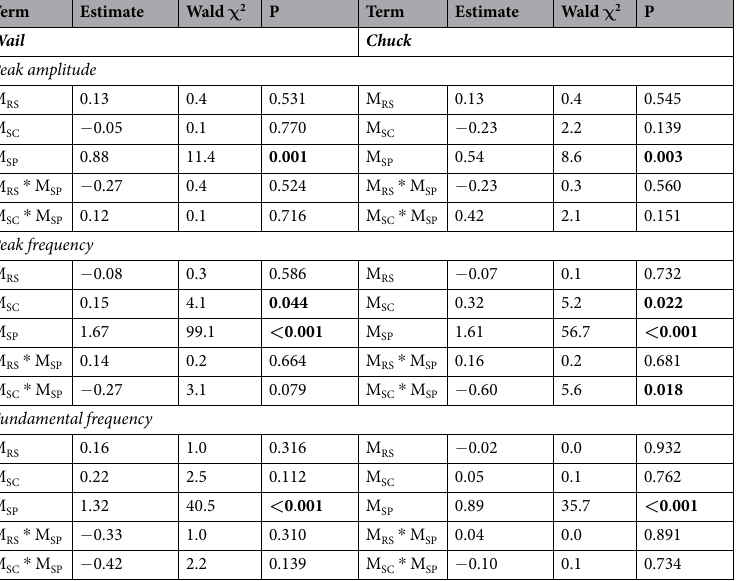
Table 1. The effect of male residency (M RS ; resident or bachelor), singing context (M SC ; spontaneous or induced) and song progression (proportion of song duration; M SP ) on peak amplitude per bout, peak frequency per bout, and fundamental frequency per bout in the wail and chuck elements of hyrax male songs. df = 1 in all effect